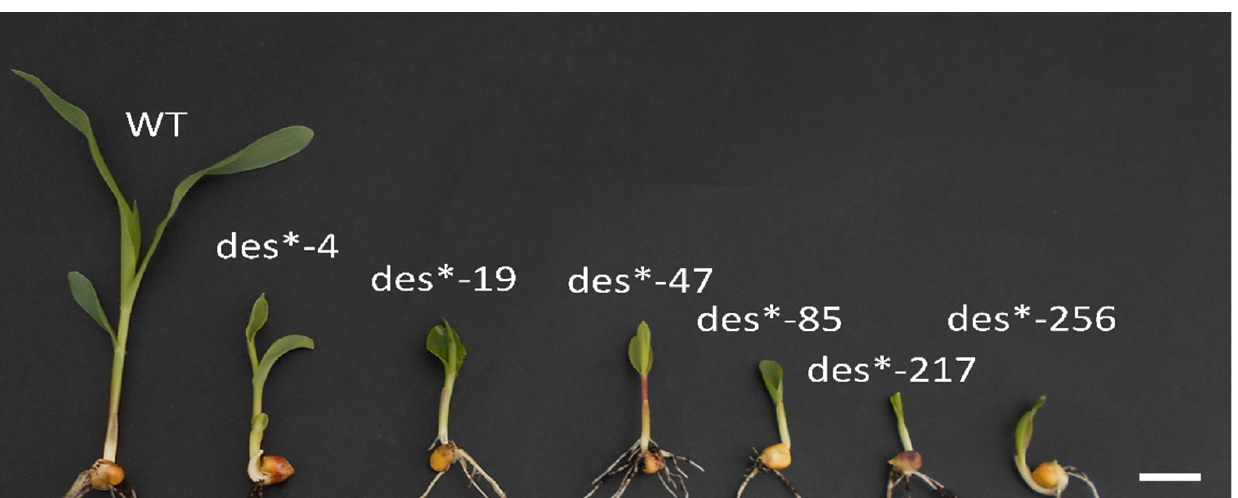
Table 1. Results for the segregation of mutant phenotypes. m: mutant, Sig: significance (NS = not